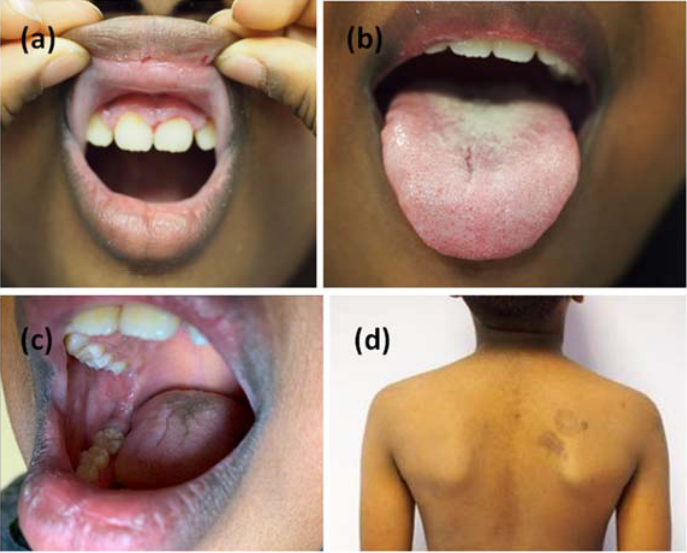
Figure 3. Complete remission of the mucous lesions ( a – c ). Pigmented outcomes on the skin ( d ).